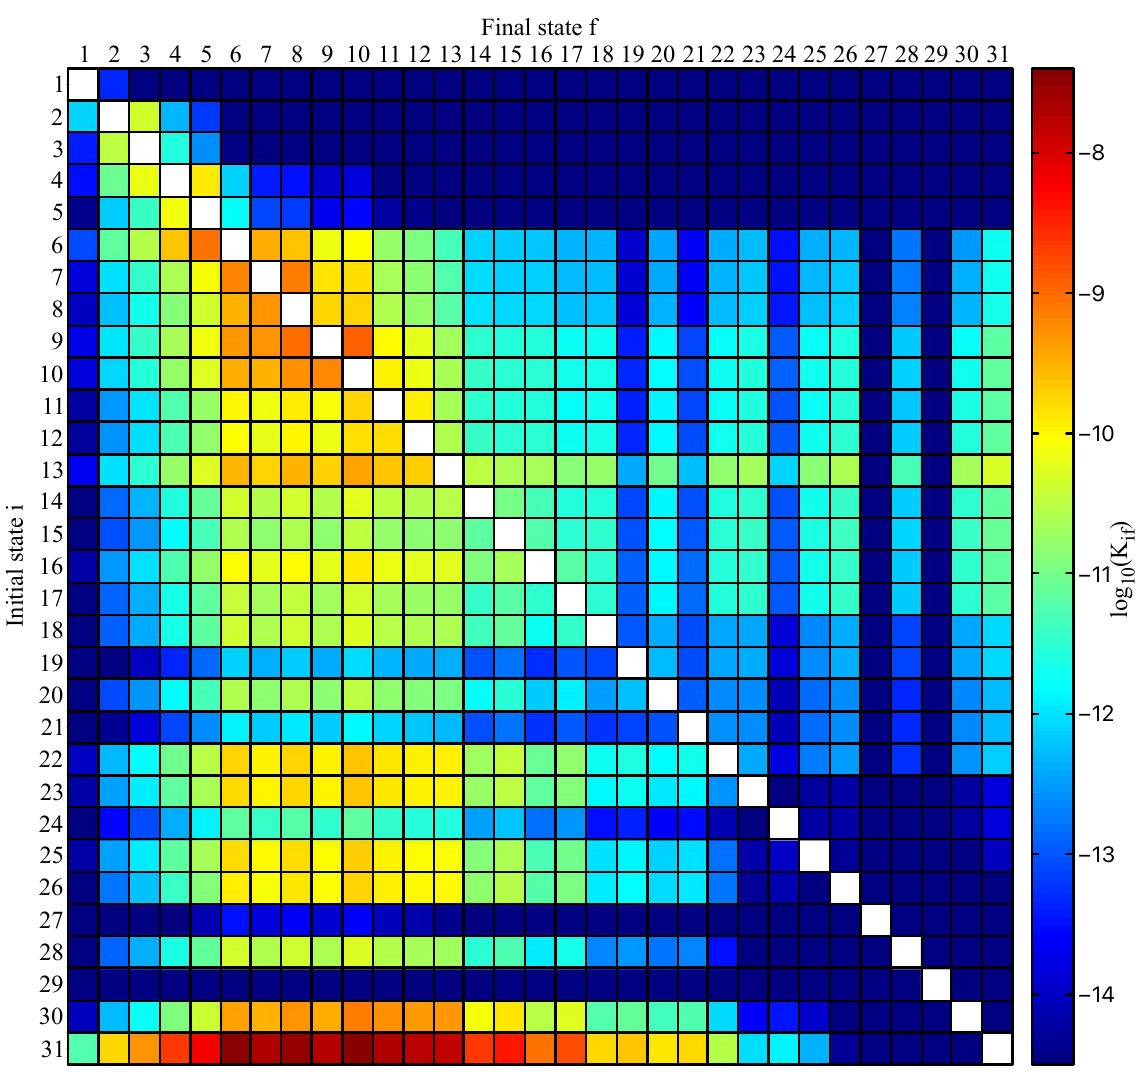
(cid:0) (cid:1) + 4 p 6 nl 2 L j